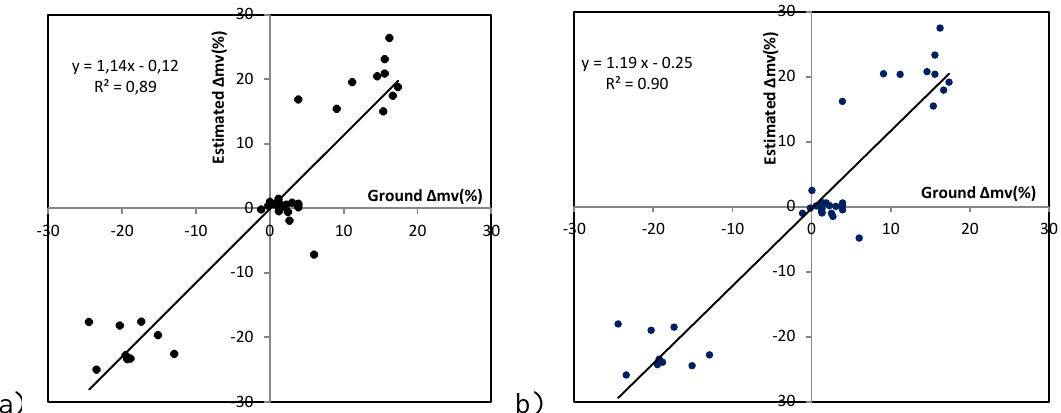
Figure 6. Validation of the two proposed change detection approaches over 15 test fields (each point corresponds to one moisture change between two successive images in one test field): ( a ) assuming no change in roughness; ( b ) taking roughness changes into account.